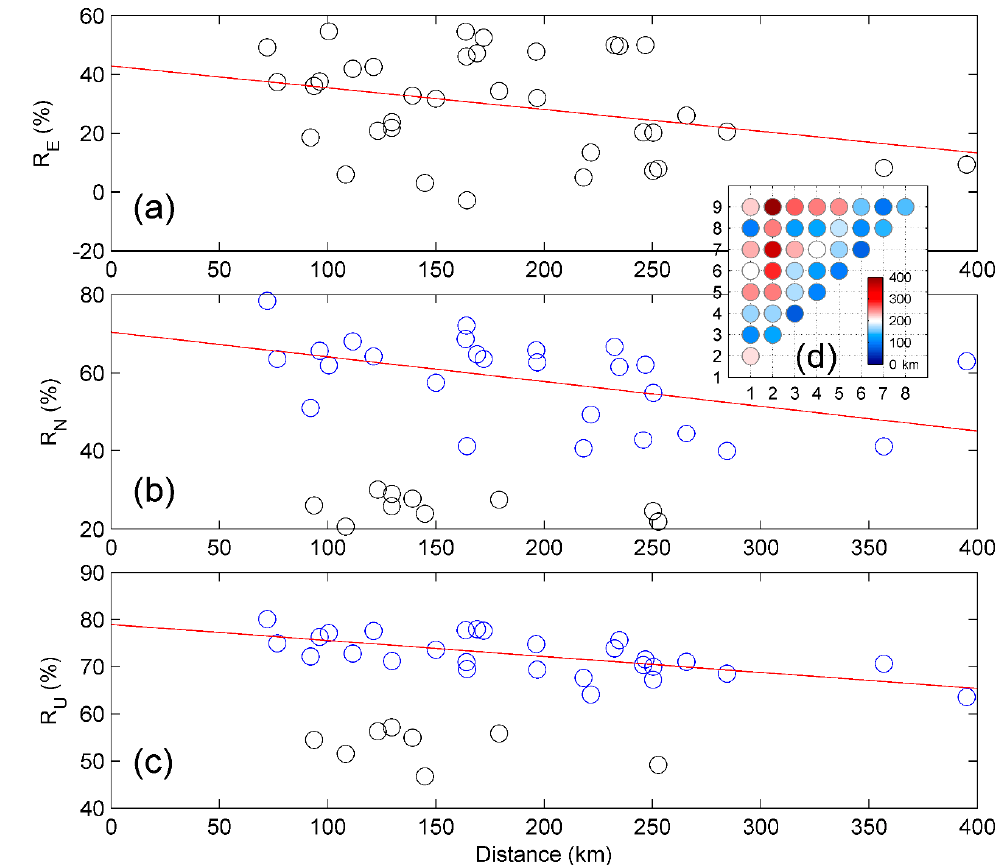
Figure 3. Inter-station distance vs. correlation coefficients for ( a ) east, ( b ) north, ( c ) up components, and ( d ) the inter-station distances. The circles in blue show that the correlation coefficients decrease as the distances increase; while the circles in gray denote there is no apparent linear correlation.